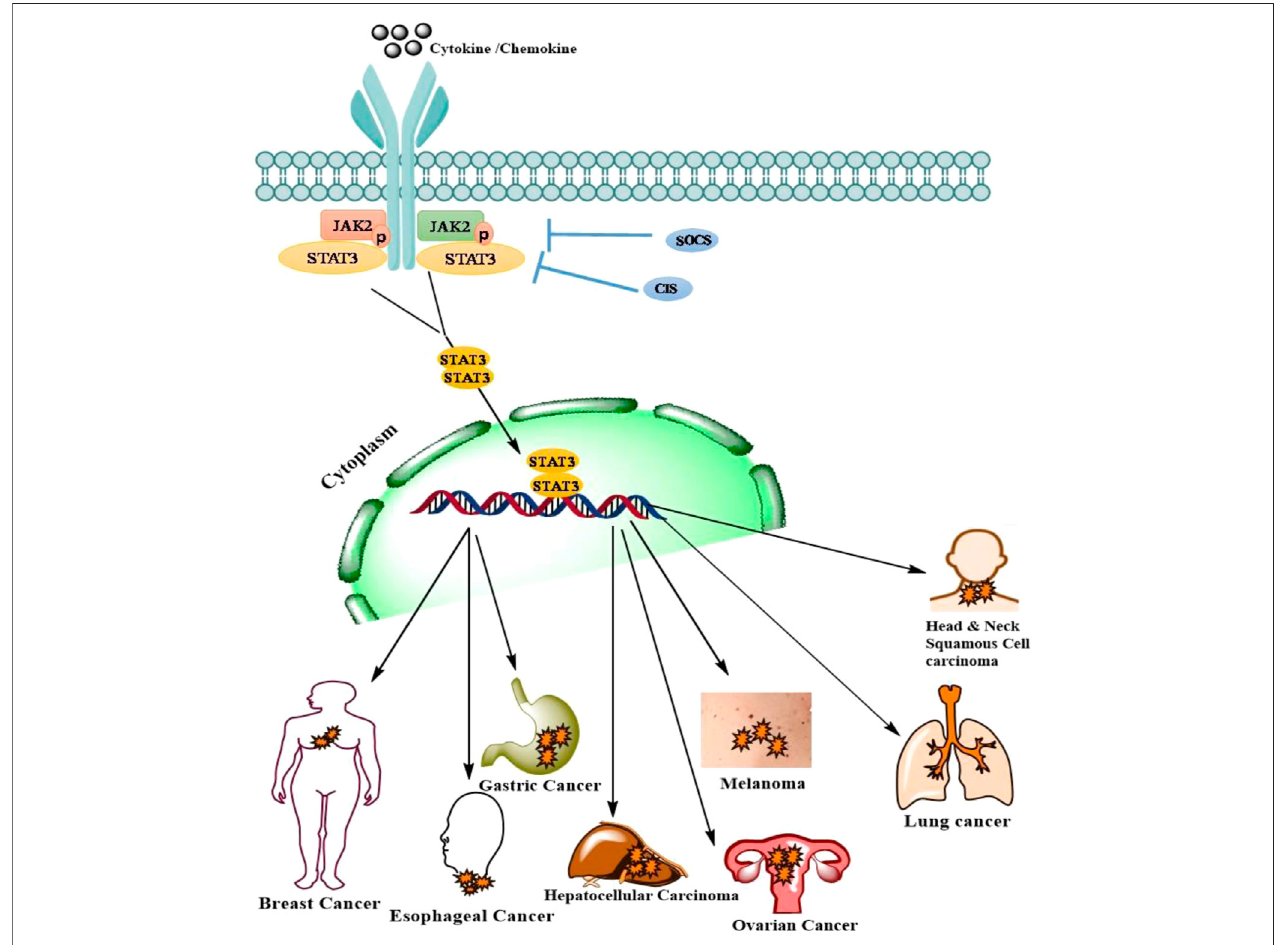
FIGURE 2 | Represents the signaling mechanism of JAK/STAT and its contribution in the pathogenesis of various solid malignancies. JAK/STAT signaling in Melanoma.